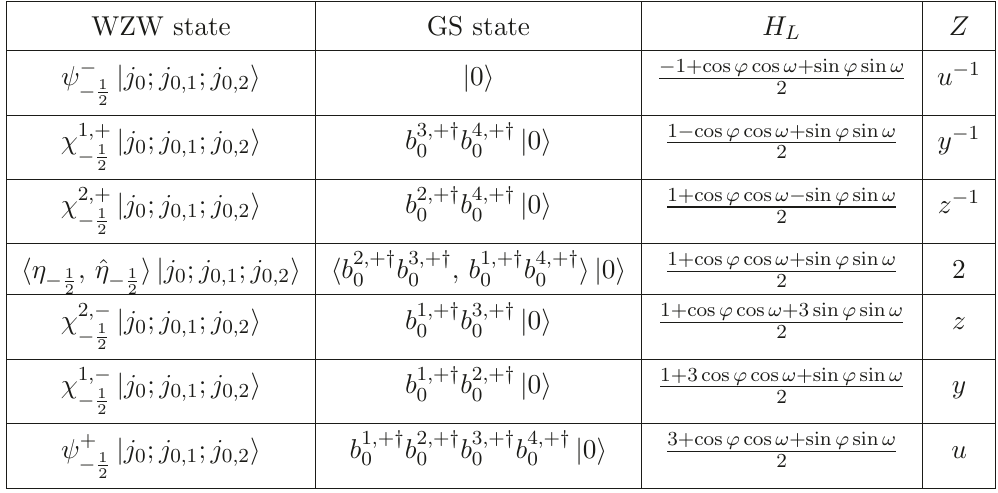
Table 3 . Low-lying states in the NS sector. In the left column we describe the states in terms of the fermionic modes in the WZW language. In the second column, we describe them in terms of the GS fermionic zero-modes; note that NS sector states correspond to an even number of GS fermions. In the remaining two columns we write the contribution to the (holomorphic) Hamiltonian and to the partition function described